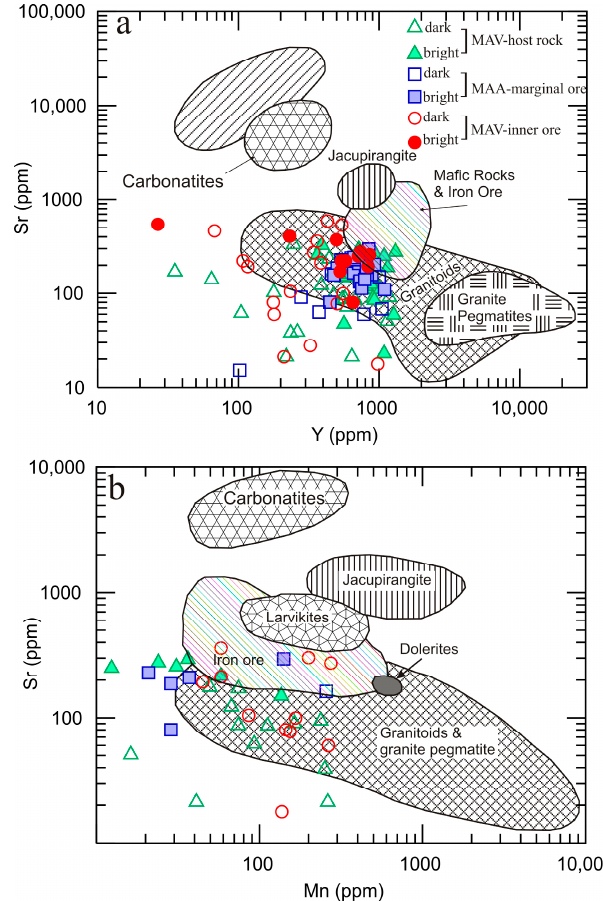
Figure 11. Sr versus Y ( a ) and Sr versus Mn ( b ) plots for Chadormalu apatites. Note that most data plot in the granitoid and iron ore fields. The fields were defined by [54].